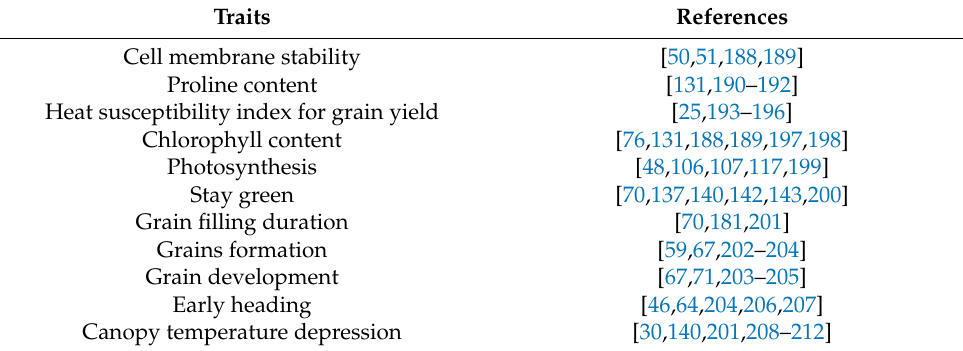
Table 2. Major desirable selection criteria for the screening heat tolerance in wheat.